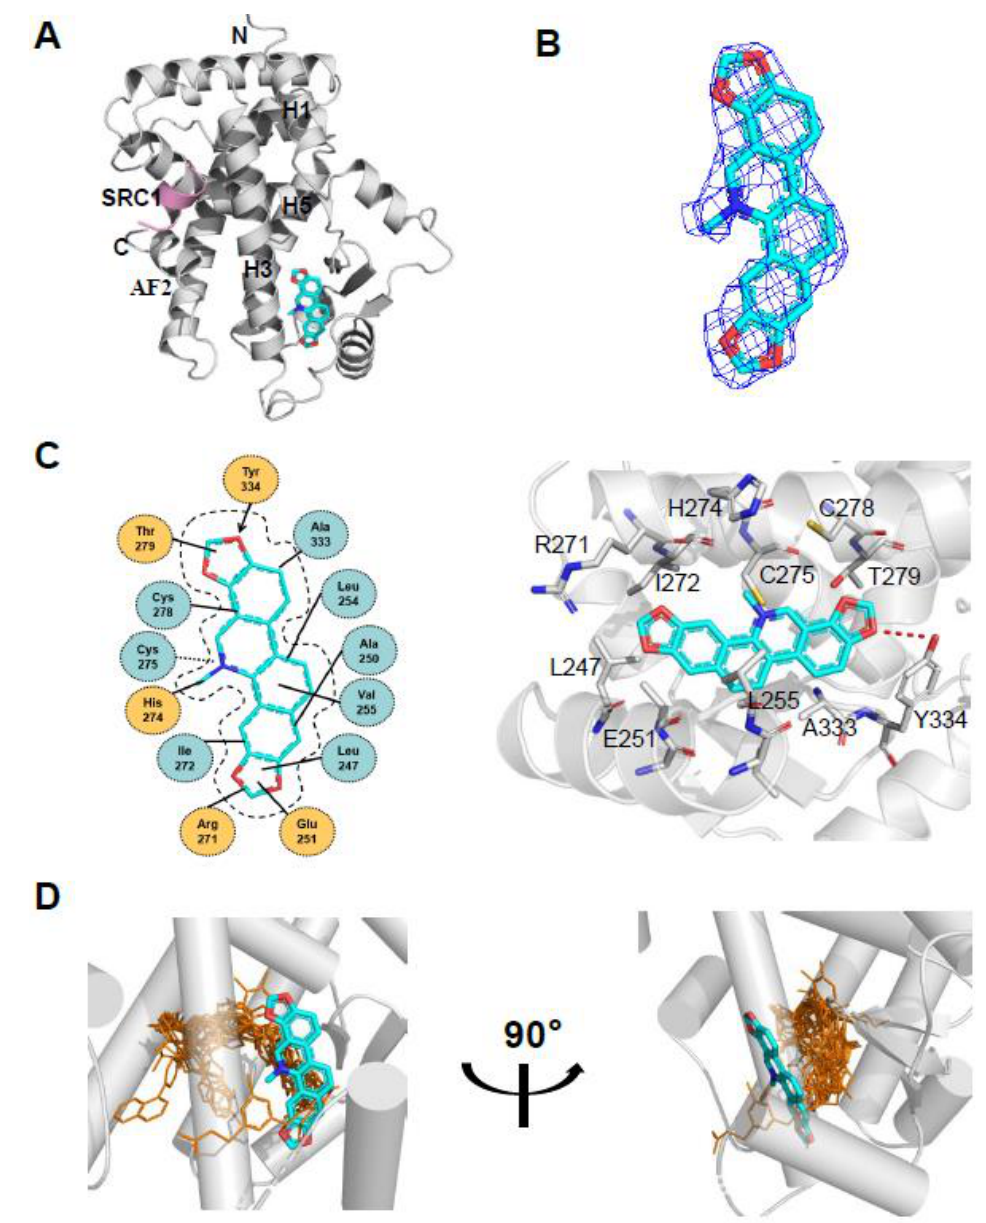
Figure 4. Structural analysis of the recognition of sanguinarine by PPAR α . ( A ) The structure of sanguinarine bound with PPAR α in cartoon representation. PPAR α is colored in gray, and the SRC1-2 motif in pink. The bound sanguinarine is shown in stick representation with carbon, nitrogen, and oxygen atoms depicted in cyan, blue, and red, respectively. ( B ) A simulated-annealing 2Fo-Fc composite omit map (1.0 δ ), showing the bound sanguinarine. ( C ) Key interactions of PPAR α with sanguinarine. Red dashes represent hydrogen bond interaction. ( D ) Comparison of PPAR α complexes. Superposition of reported PPAR α complexes with agonists (PDB: 1I7G, 1K7L, 2NPA, 2P54, 2ZNN, 3ET1, 3FEI, 3G8I, 3KDU, 3SP6, 3VI8, 4BCR, 4CI4, 5AZT, 5HYK, 6KXX and 6L96) overlaid onto the PPAR α complex with sanguinarine. Reported agonists are shown in gold lines, and sanguinarine is represented by cyan